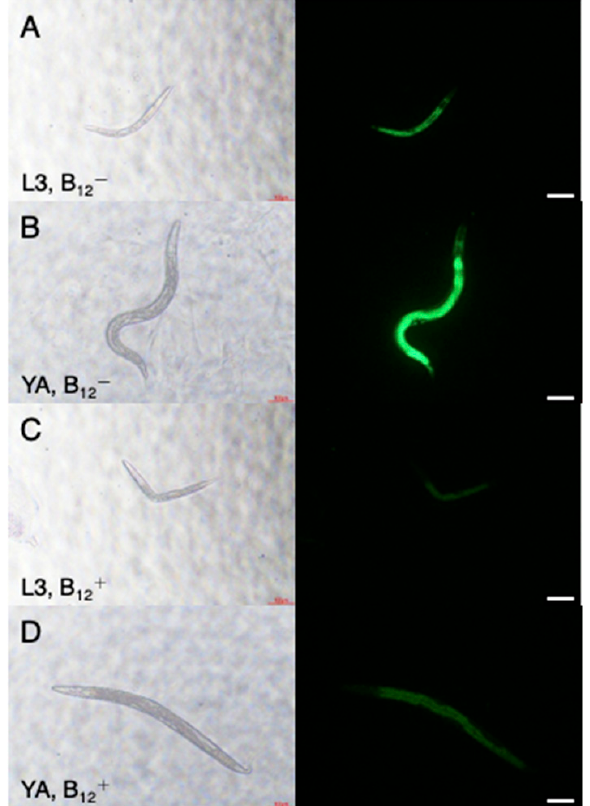
Figure 1. Representative fluorescence images of L3 and young adult VL749 B 12 − and B 12+ worms. ( A ), L3 B 12 − larva; ( B ), young adult B 12 − worm; ( C ), L3 B 12+ larva; ( D ), young adult B 12+ worm. Worms grown with B 12 supplementation, B 12+ ; without B 12 supplementation, B 12 − . Scale bars = 100 μ m.